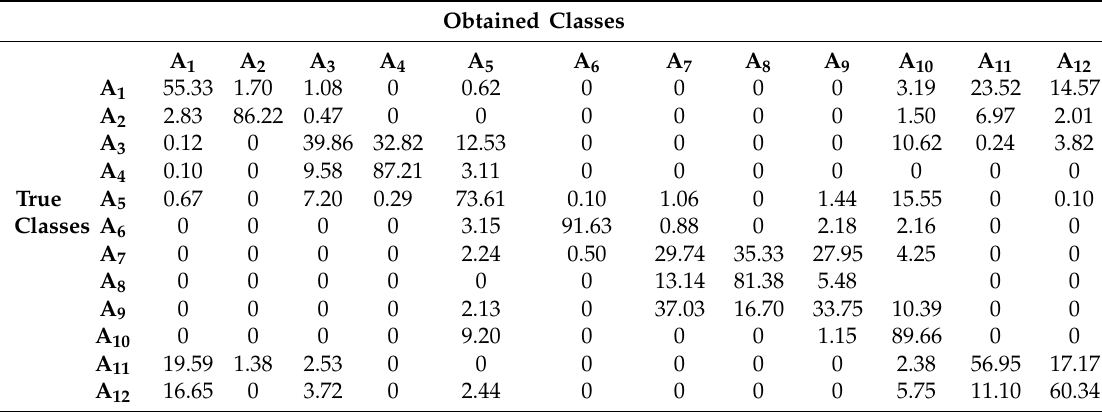
Table 6. Global confusion matrix obtained with HMM using raw